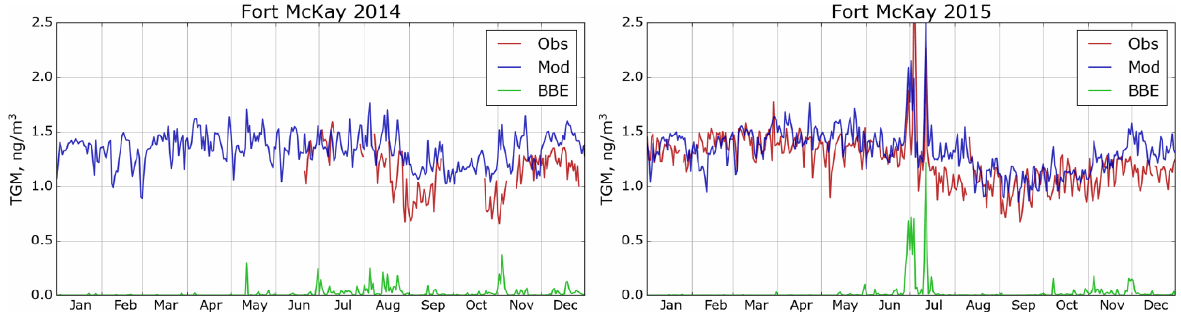
Figure 6. Simulated and observed surface air TGM concentrations in AOSR for the site Fort McKay (2014 and 2015). Obs – observations; Mod – model estimation; BBE – biomass burning